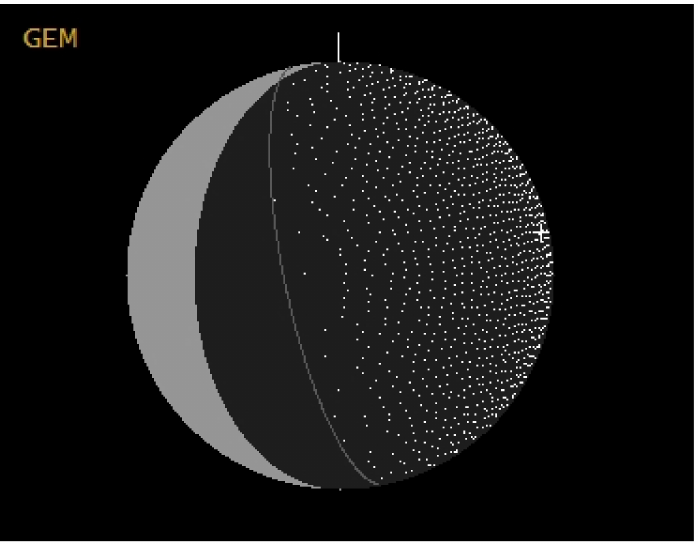
Figure 1. Impact geometry on the Moon from meteoroids of the Geminid stream, plotted by the LunarScan software for 14 December